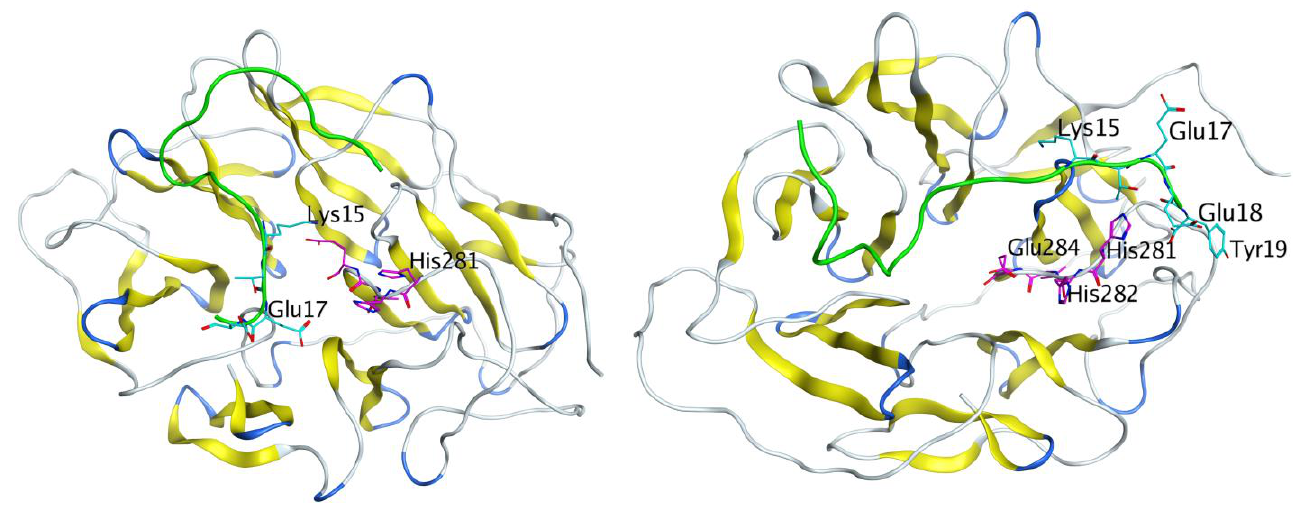
Figure 6. Interaction of angiopep-2 (marked green) with mouse LRP1 after 30 ns (left) and 50 ns of MD (right). The KTEE site is marked blue and the HHVE site in LRP1 is marked pink.